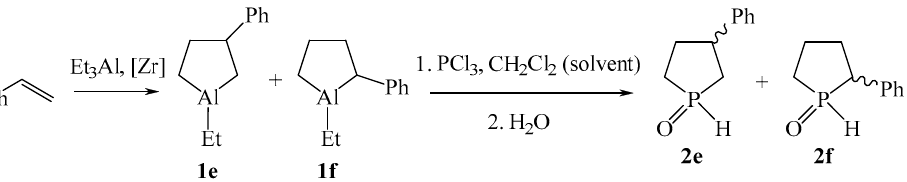
pentane 1f (Scheme 2) in a 1:2 ratio, respectively, which react in situ with PCl 3 to give